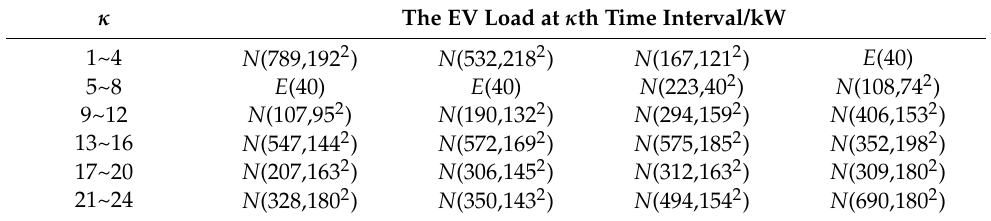
Table 2. The probability distribution of EV load change at the FCS A in different time intervals in a day. κ The EV Load at κ th Time Interval/kW